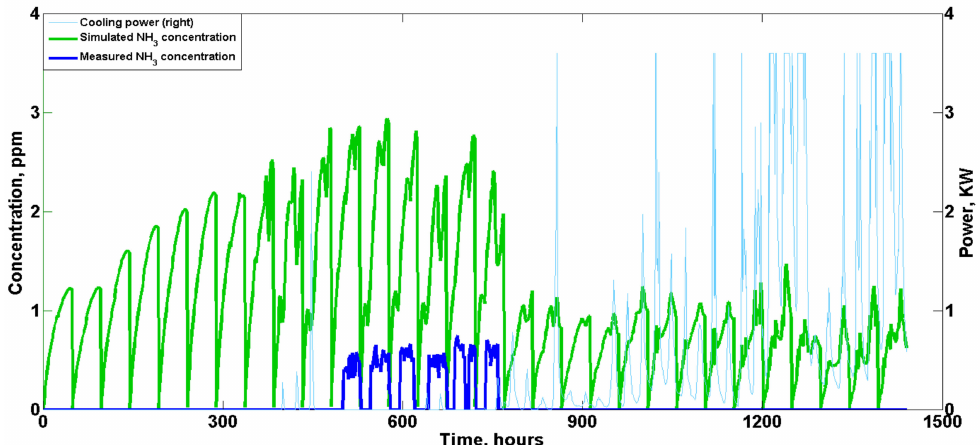
Figure 14. Simulated indoor NH3 concentration during the validation test. Note: The base ventilation is not included in the figure. The maximum rated tunnel ventilation power was 3.6 kW.